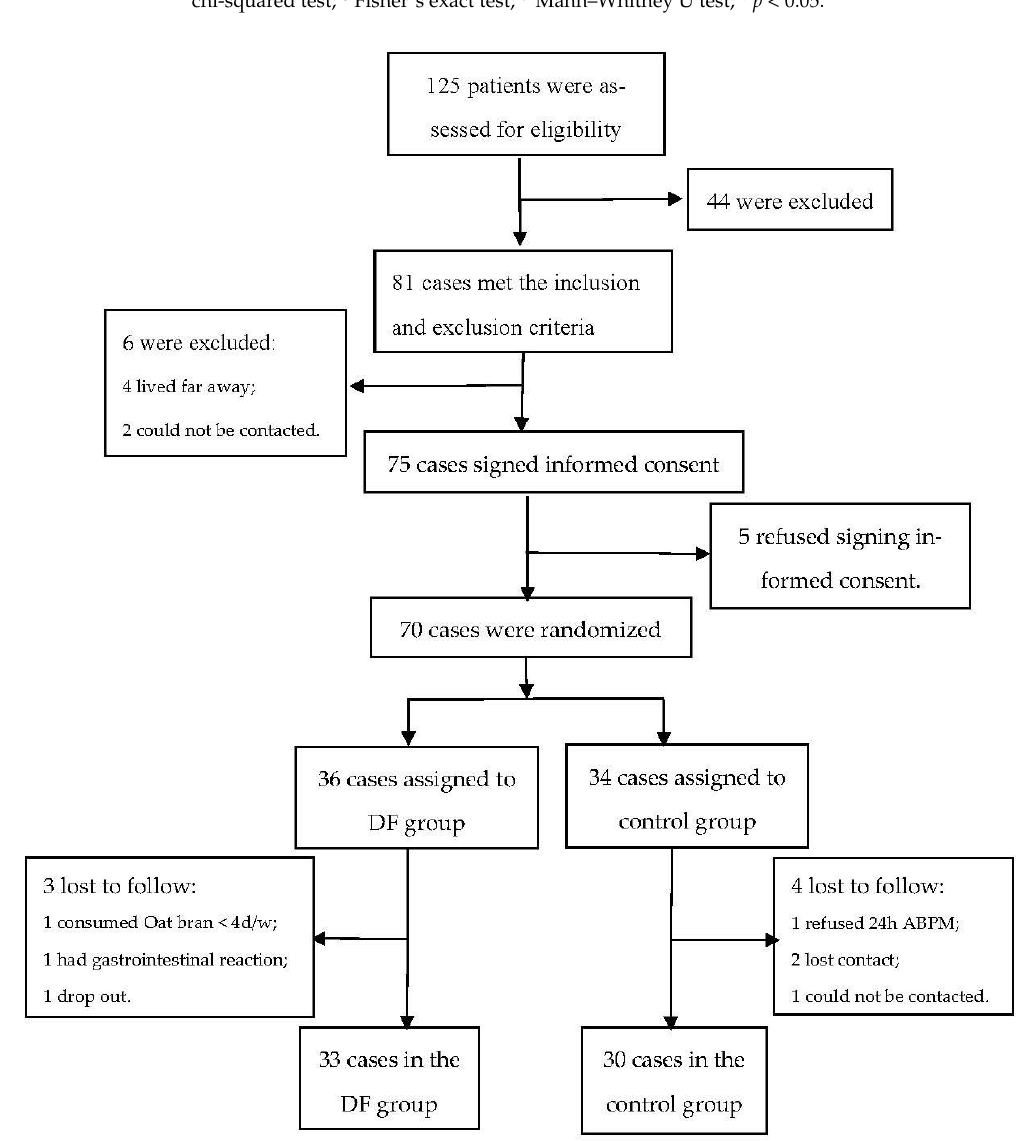
Figure 1. Trial flowchart. ABPM: ambulatory blood pressure monitoring; DF: dietary fiber. Table 1. Socio-demographic and clinical characteristics.